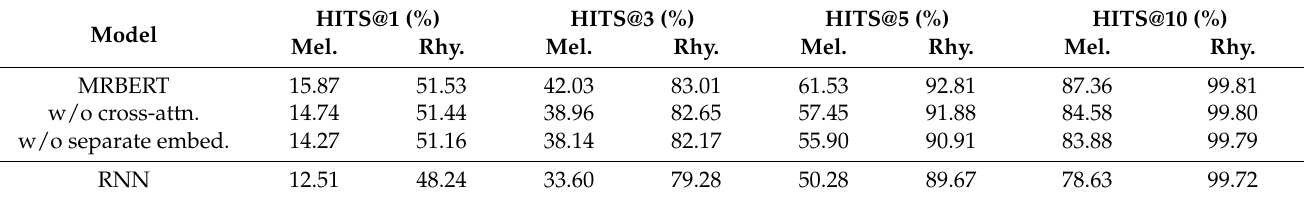
Table 3. Ablation experimental results of the autoregressive generation